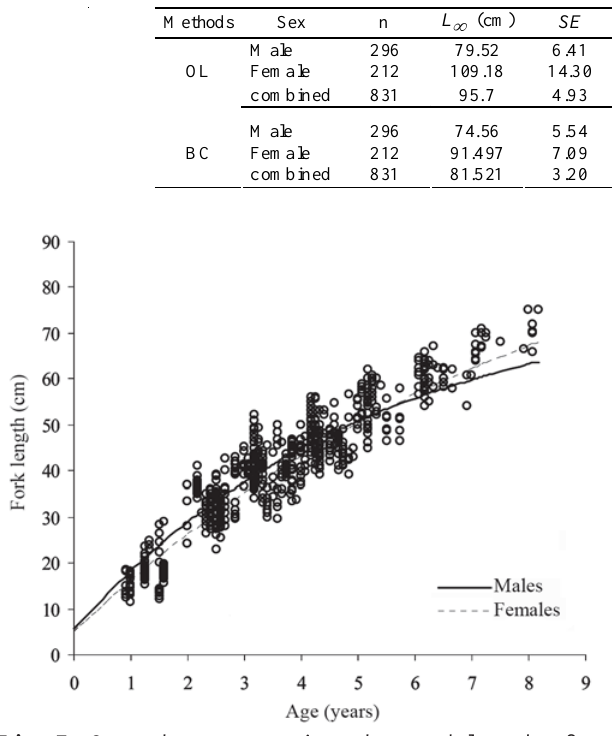
Fig. 7. Growth curves using observed lengths for Scomberomorus brasiliensis collected off northeastern